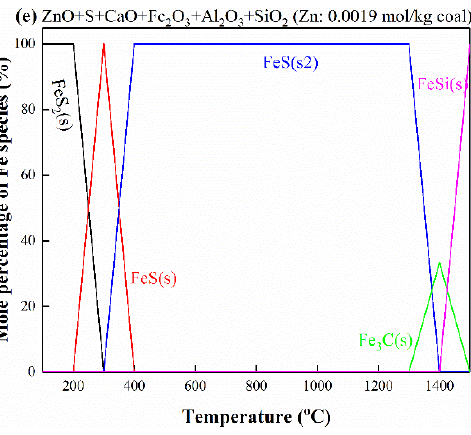
Figure 14. Thermodynamic equilibrium distributions of Zn ( a ), Ca ( b ), Al ( c ), Si ( d ) and Fe ( e ) in the coal when the Zn content is low (Zn/S/Ca/Al/Si/Fe = 0.0019/0.24/0.07/0.46/0.53/0.06). Consistent with the XRD results, when the Zn content is low (molar ratio of Zn/S < 1), ZnS and SiO 2 are the main minerals in the obtained coke, and ZnS, ZnAl 2 O 4 and SiO 2 can be detected when the Zn content is high (molar ratio of Zn/S > 1). In addition, CaS is